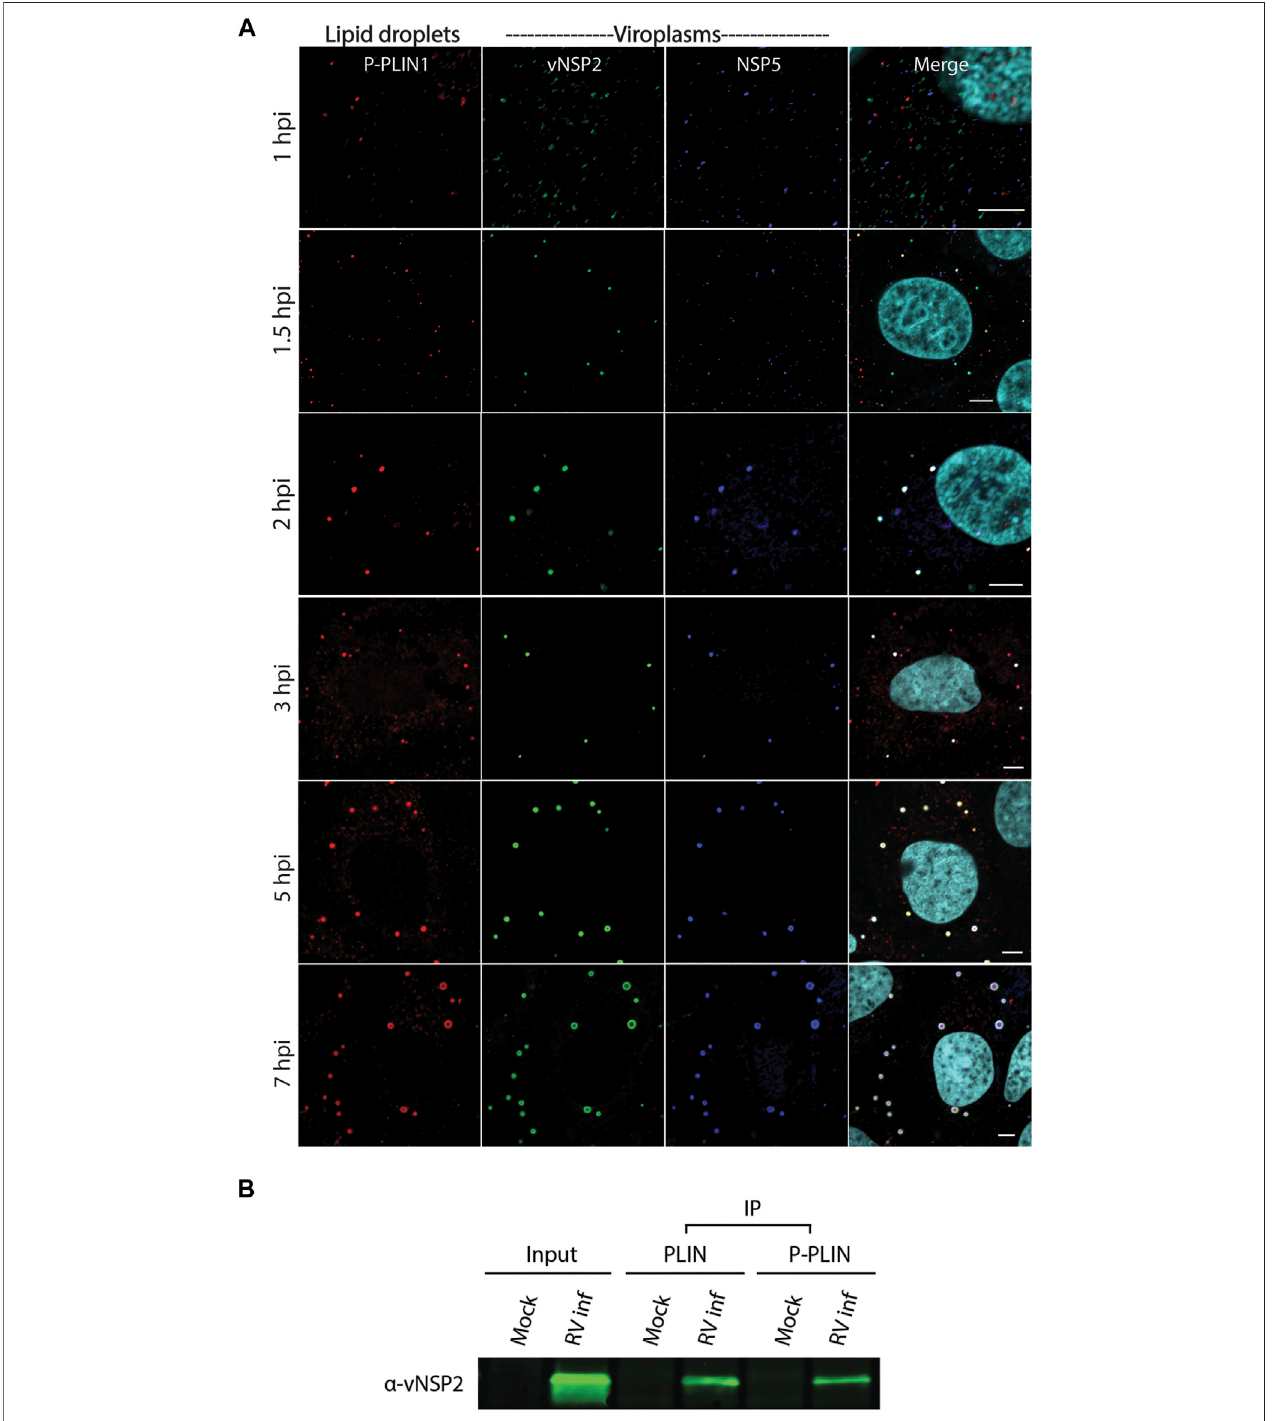
FIGURE 2 | RV viroplasmic proteins vNSP2 and NSP5 colocalize with lipid droplets early in infection. (A) Immuno fl uorescence confocal microscopy was used to detect lipid droplets and viroplasms in RV-infectedcells at 1, 1.5, 2,3, 5, and 7hpi. Mouse anti-phospho-PLIN1(red) wasused todetect lipid droplets. Viroplasms were detected using mouse monoclonal antibody anti-vNSP2 (green), and guinea pig polyclonal antibody anti-NSP5 (blue). Nuclei were detected with DAPI (light blue). Scale bar = 5 µm. Previously unpublished data. Immuno fl uorescent assay performed as described in Criglar, 2020 (Criglar et al., 2020). (B) Western blot of vNSP2 co- immunoprecipitated with PLIN1 or P-PLIN1 from RV-infected cell lysates. [From Criglar, et al., 2020 (Criglar et al., 2020)].